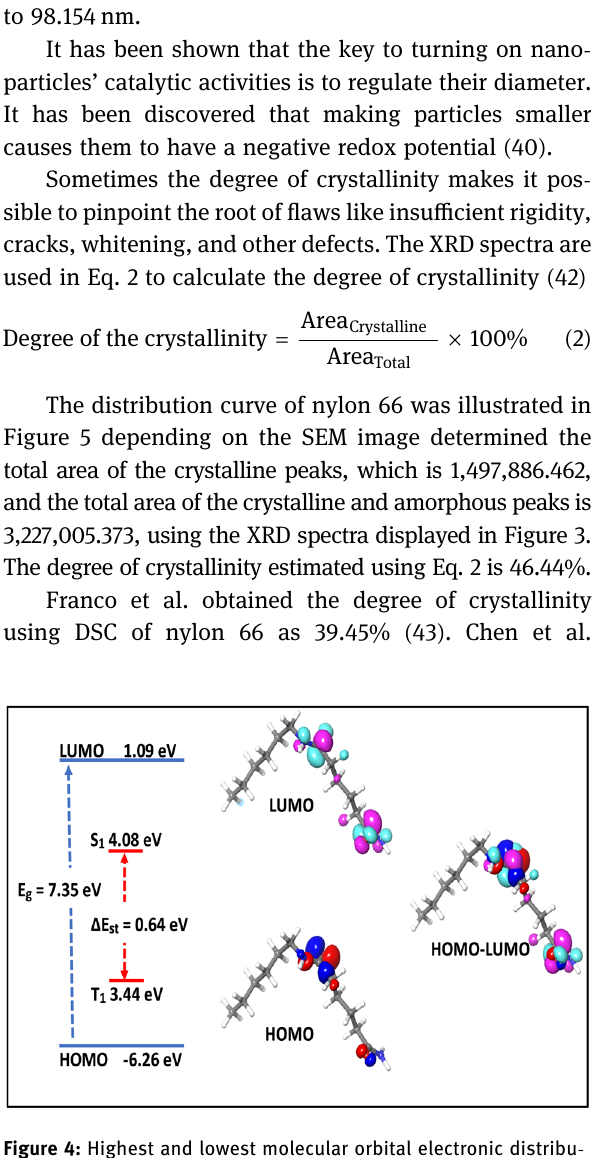
Figure 4: Highest and lowest molecular orbital electronic distribu - tions, energy level, and bandgaps ( E g ) , the lowest singlet ( S 1 ) , and triplet ( T 1 ) of nylon